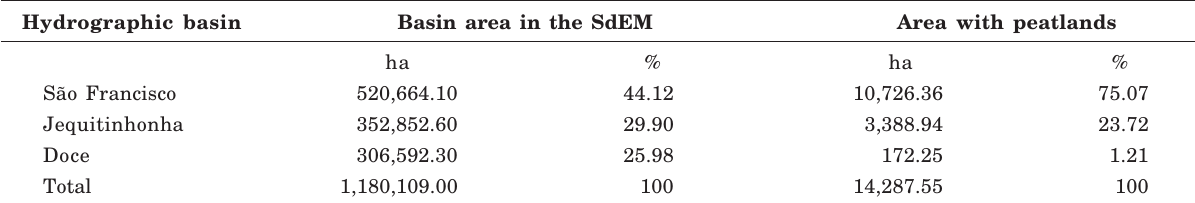
Table 5. Mapped area with peatlands in hydrographic basins in the Hydrographic basin